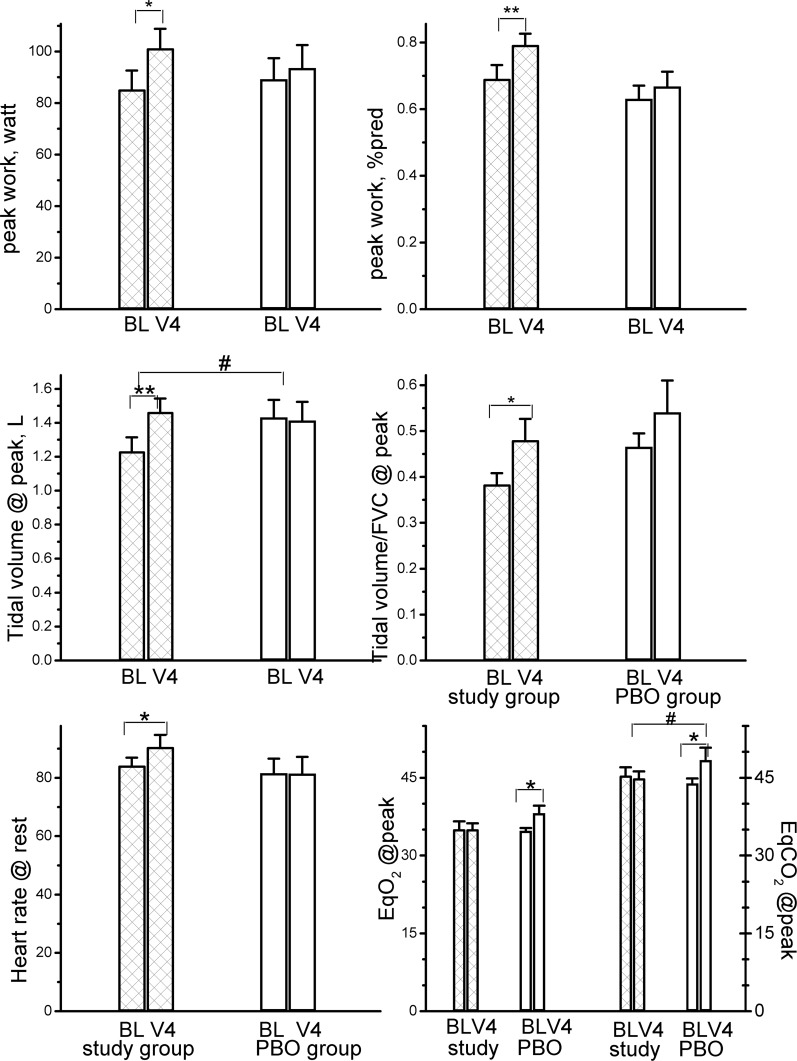
Differences in the selected variables from maximum incremental exercise test between the Rhodiola crenulata group and placebo (PBO) group over the 12-week treatment period.BL = baseline, V4 = visit at 12 weeks, EqO2 and EqCO2 = ventilatory equivalents for O2 uptake and CO2 output, bars: standard error. *comparisons within group: p < .05, ** comparisons within group: p < .01, #comparisons between groups: p < .05.